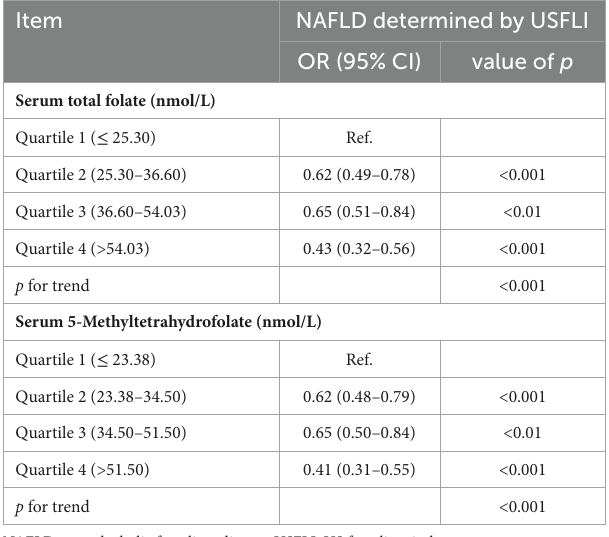
TABLE 2 Associations between serum total folate and 5-Methyltetrahydrofolate levels with NAFLD in NHANES 2011–2018.